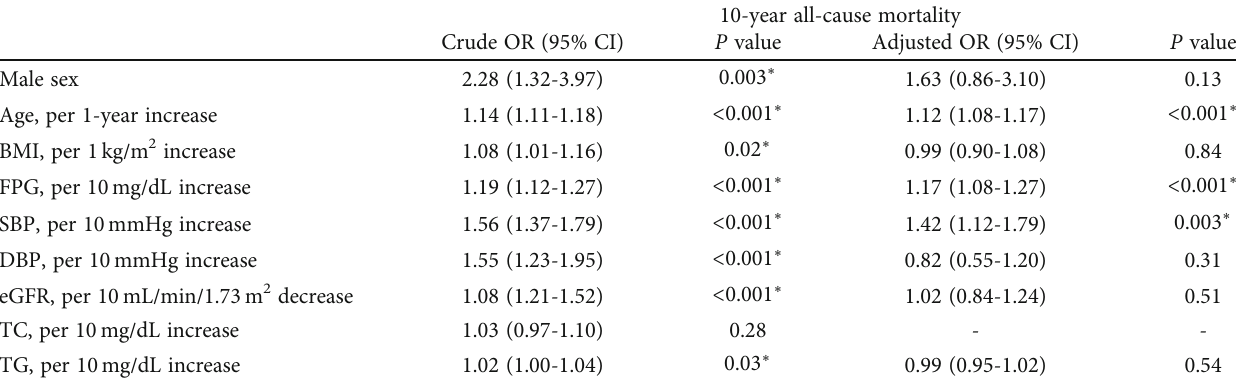
Table 2: Univariable and multivariable logistic regression analysis of baseline metabolic parameters in prediction of all-cause mortality during the 10-year follow-up.